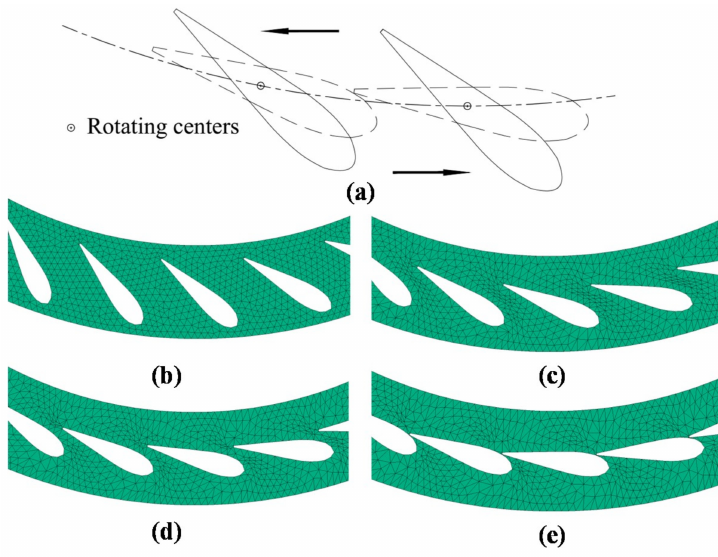
Figure 4. ( a ) Closing process of the guide vanes, ( b ) t = 0 s, ( c ) t = 2.2 s, ( d ) t = 4.2 s, and ( e ) t = 6.3 s.